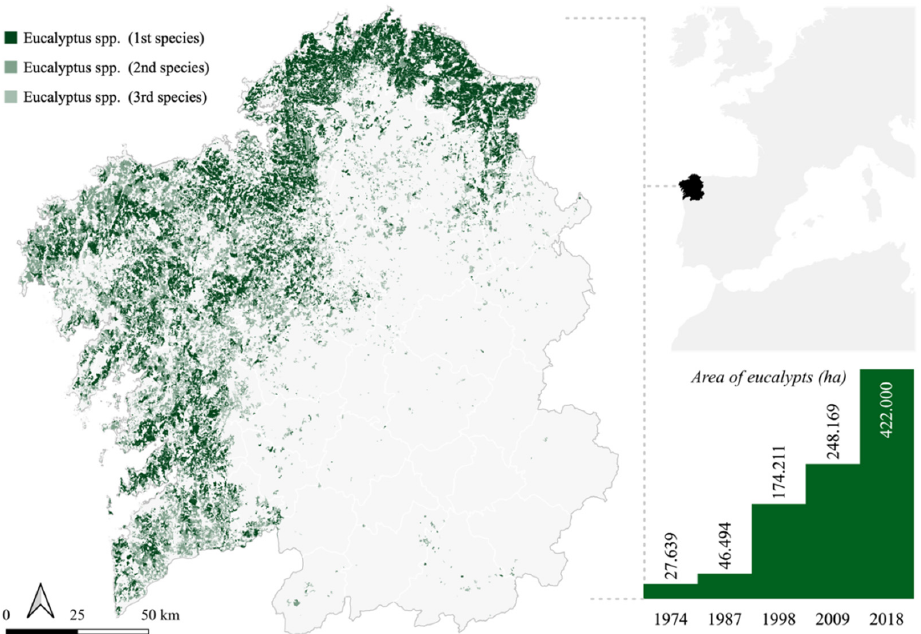
Figure 1. The contemporary expansion of eucalypt masses in Galicia, Spain. Map by Diego Cidrás with data of the Spanish Forestry Map (1:25,000).